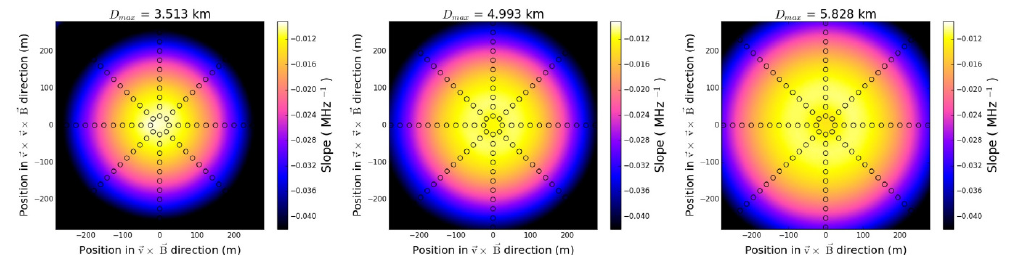
Figure 2. Distribution of the linear-fit slope on the shower plane for three simulated events with di ff erent values of D max . Slope values of the 160 antennas (open circles) used for the simulation procedure have been interpolated in order to create a smooth background.